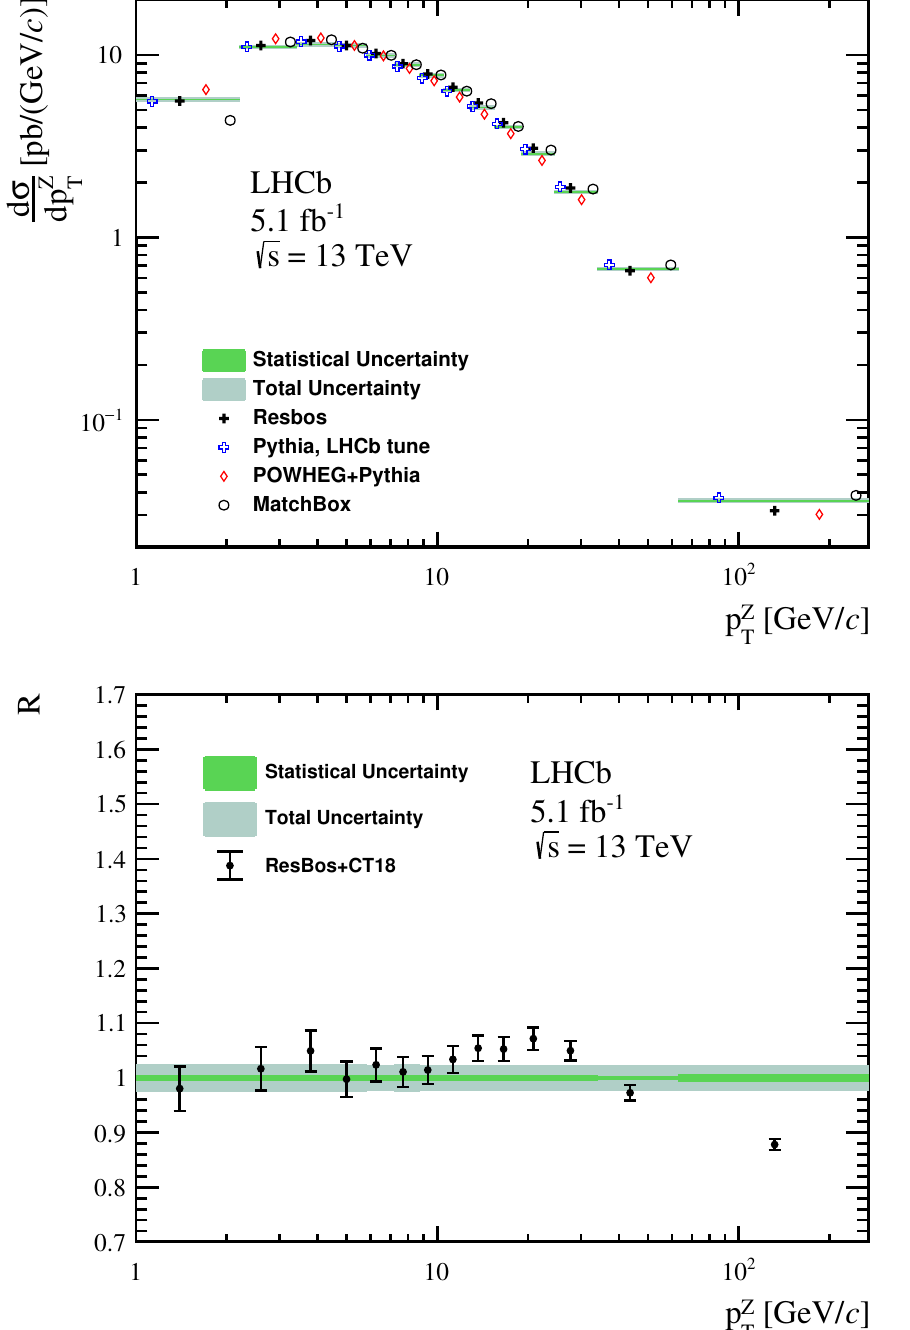
Figure 4 . (Top) Measured single differential cross-section in regions of p Z theoretical predictions. (Bottom) Ratio of ResBos predictions to measurement, with the horizontal bars showing the uncertainty from the